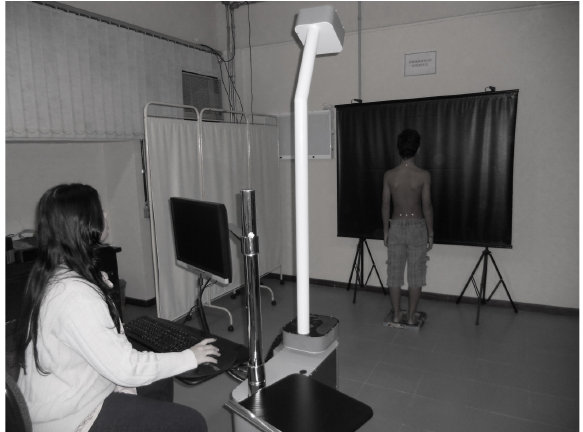
Figure 1 - The physical structure of the Vert-3D system, and child positioned for the exam.